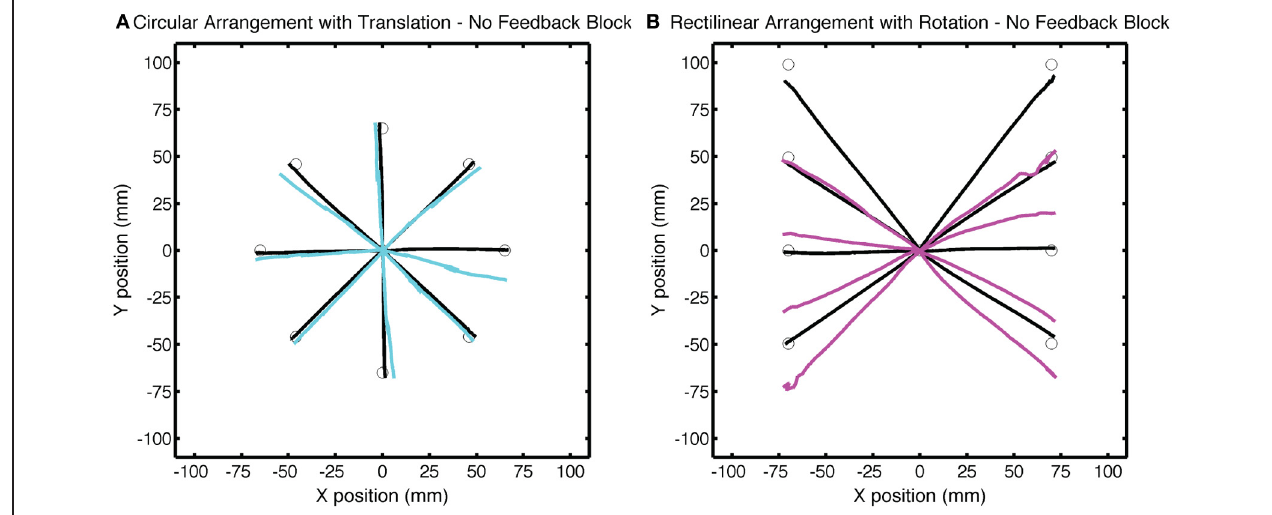
FIGURE 8 | Group averaged trajectories during the No Feedback block in Experiment 2 for the (A) CircleTranslation group (cyan) and (B) LineRotation group (purple) compared with